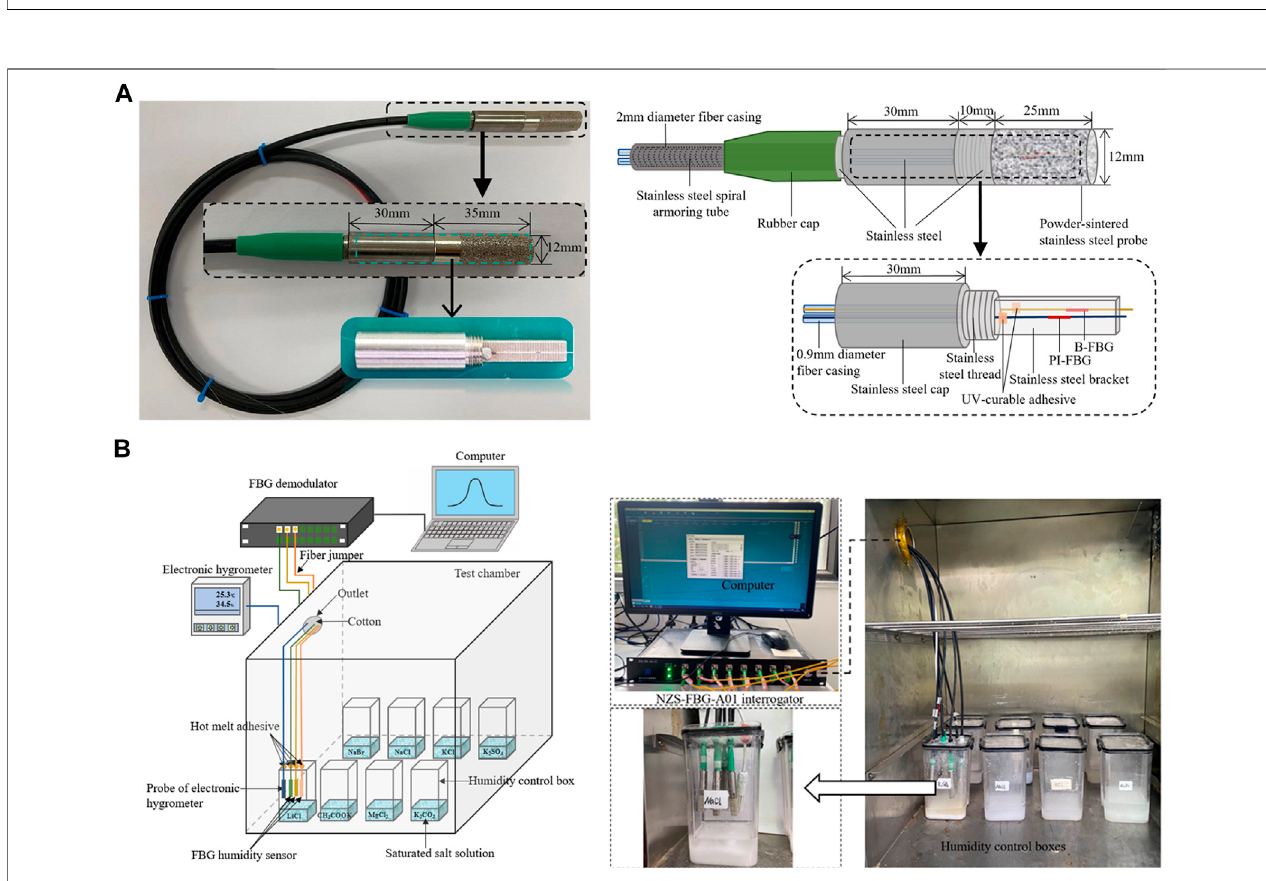
Frontiers in Sensors |